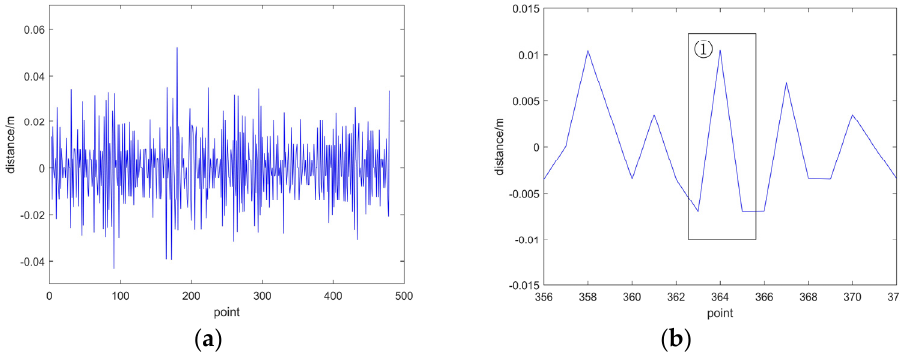
Figure 6. ( a ) ∆𝑘(cid:4666)𝑖(cid:4667) after data point calculation; ( b ) distribution diagram at corner ∆𝑘(cid:4666)𝑖(cid:4667) . Figure 6. ( a ) ∆ k ( i ) after data point calculation; ( b ) distribution diagram at corner ∆ k ( i The calculation formula of 𝑆𝑆𝐸 (Sum of the Squared Errors) for line segment fitting errors is shown in (14).